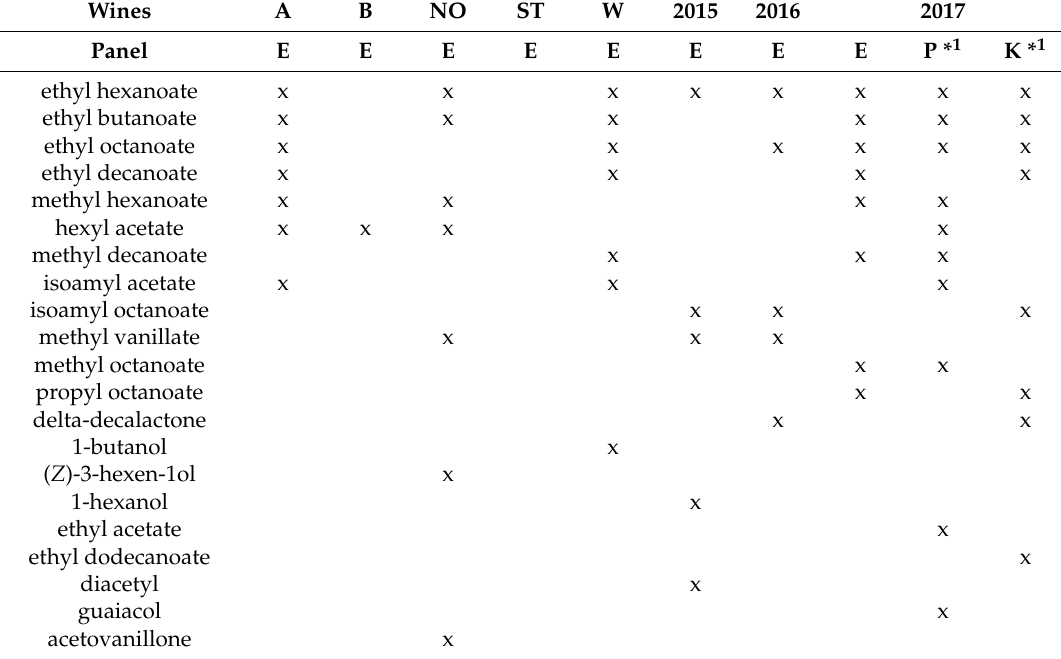
Table 3. Volatile compounds found significantly ( α ≤ 0.05) in typical Pinot blanc wines compared to atypical wines in higher quantities, ranked by frequency of significant di ff